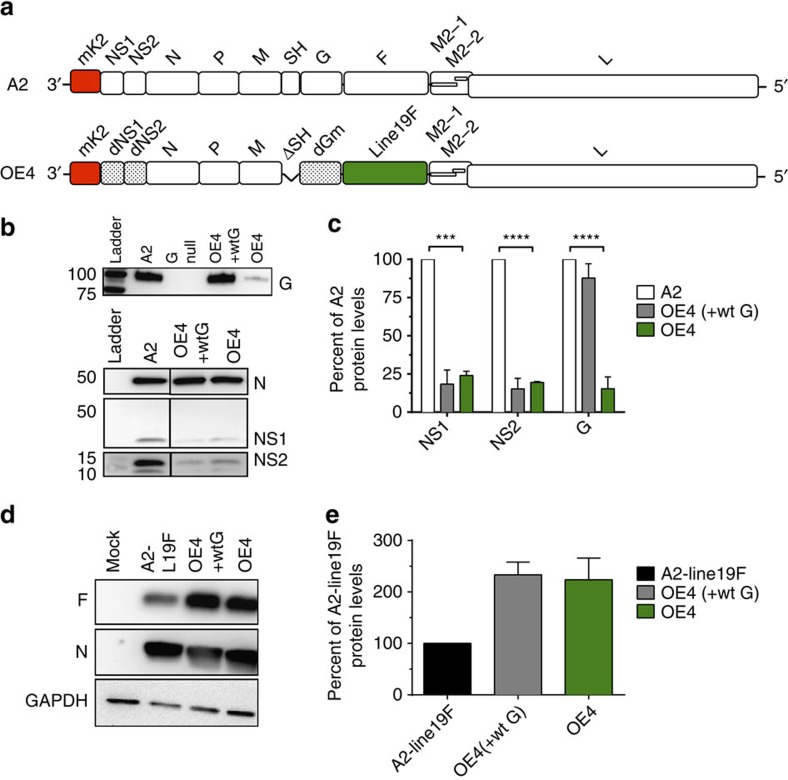
Design of live-attenuated vaccine OE4 and expression of viral proteins.(a) Schematic of RSV LAV OE4 genome including codon deoptimization of the NS1, NS2 and G genes, deletion of the SH gene, and incorporation of the line 19F gene. (b) Western blotting of Vero cells infected with A2 (white), OE4 (green) or OE4 expressing wild-type G (OE4-wtG, grey) for NS1, NS2, N and G. An A2-Gnull mutant was included as a control. (c) Western densitometry analyses were normalized to A2 expression levels. (d) Western blotting of Vero cells infected with mock, A2-line19F (white), OE4-wtG (grey) or OE4 (green) for F, N and GAPDH. (e) Densitometry results were normalized to A2 expression levels. Densitometry results represent the means+s.d.'s of at least two experimental replicates and representative blots are shown. Statistical analyses were performed by one-way ANOVA (***P<0.0005; ****P<0.00005). d, codon-deoptimized; F, fusion protein; G, attachment glycoprotein; L, large polymerase; M, matrix; mK2, monomeric Katushka2; N, nucleoprotein; NS1/NS2, nonstructural proteins 1 and 2; P, phosphoprotein; SH, small hydrophobic protein.